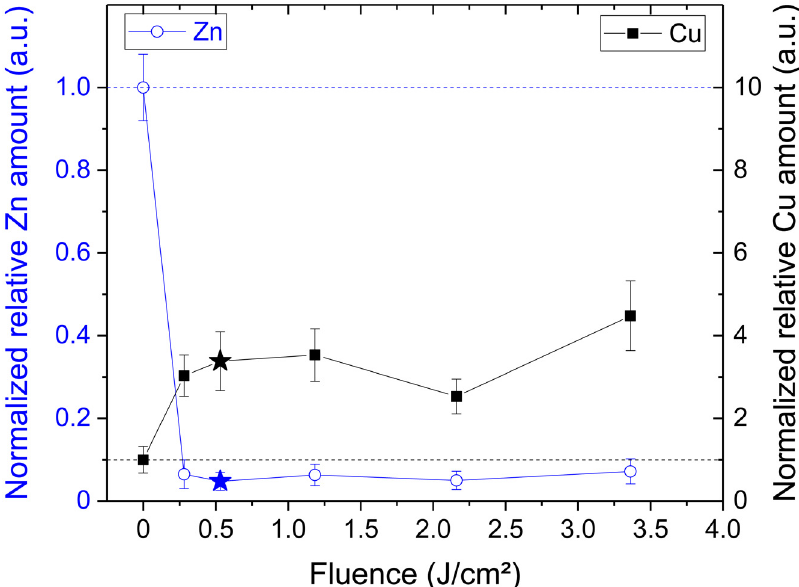
Fig. 6. EDX investigation of the material composition in the iso-cut scribe lines as a function of the applied laser fl uence. The blue open circles are assigned to elemental Zn (L line), which is an indicator for the window layer stack (left y -axis). The black squares refer to elemental Cu (L line), which represents the underlying CIGSe absorber (right y -axis). The selected fl uence is marked with an asterisk.